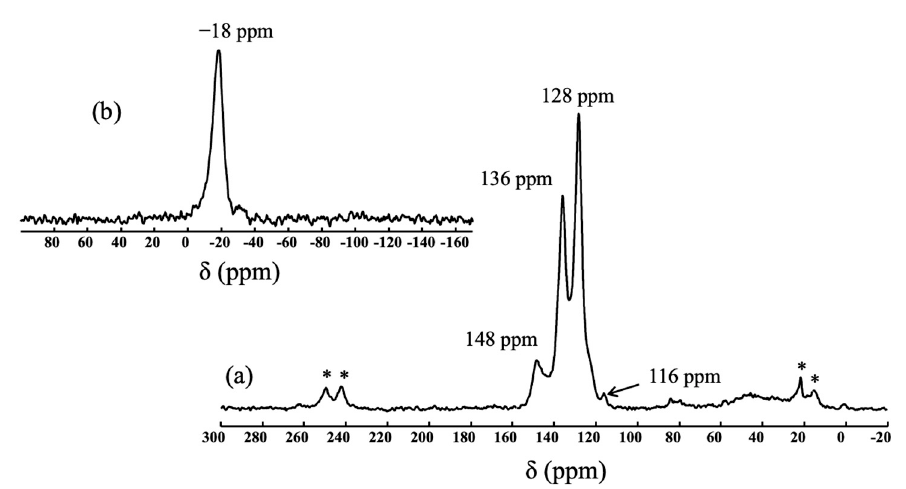
Figure 3. ( a ): 13 C CPMAS NMR spectrum of l -hPZCS ; * indicates rotation bands; ( b ): 29 Si CP MAS NMR spectrum of l -hPZCS . Table 1. Characteristics of the different synthesised polymers and their respective yields.